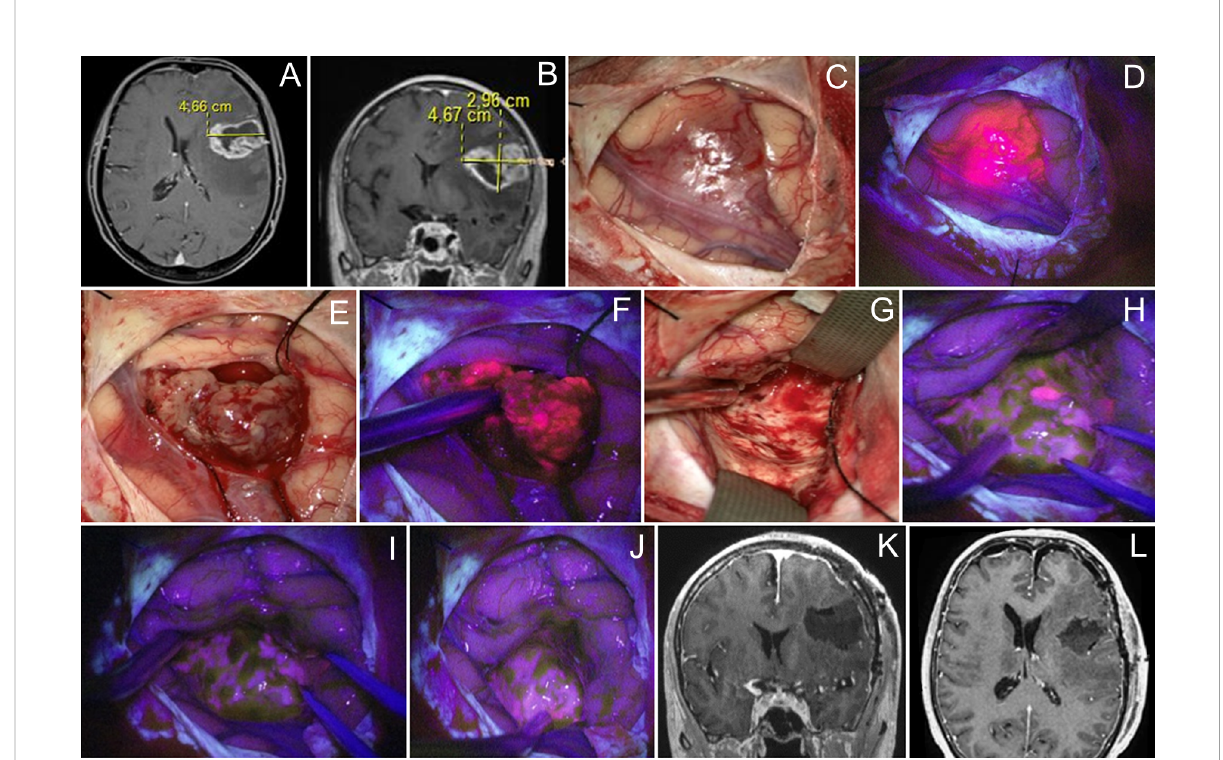
FIGURE 3 Case 3. A 46 year-old woman with left frontal glioblastoma located in the middle frontal gyrus projection. Contrast-enhanced axial (A) and coronal (B) MR images. Intraoperative images show that the tumor grows onto the cortex surface (C) with bright fl uorescence of the cortex in the Blue400 mode (D) . Tumor core (E) exhibited bright fl uorescence (F) . At the end of resection under white light (G) , residual fl uorescent tumor focus is identi fi ed and resected after negative subcortical mapping. Final inspection under the Blue400 mode showed no residual fl uorescence (H, I) ; one fl uoropositive focus was revealed at the depth of the postoperative cavity (J) . Postoperative coronal (K) and axial (L) contrast-enhanced T1-weighted MR images demonstrate gross total resection of the